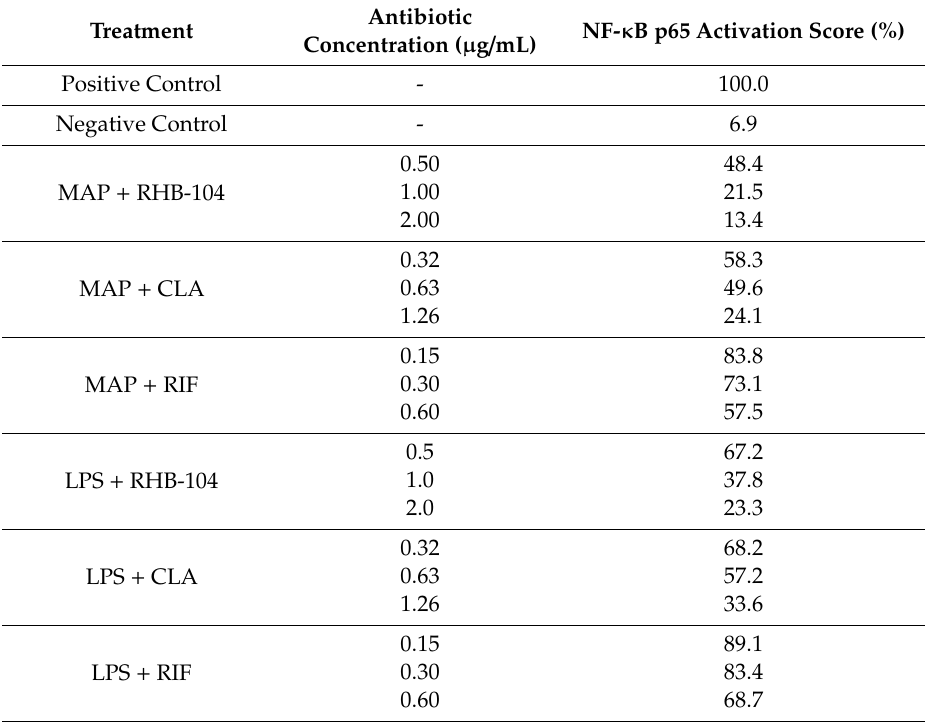
Table 2. NF- κ B p65 activation scores in macrophages infected with MAP or treated with LPS following treatment with RHB-104 and its major components.